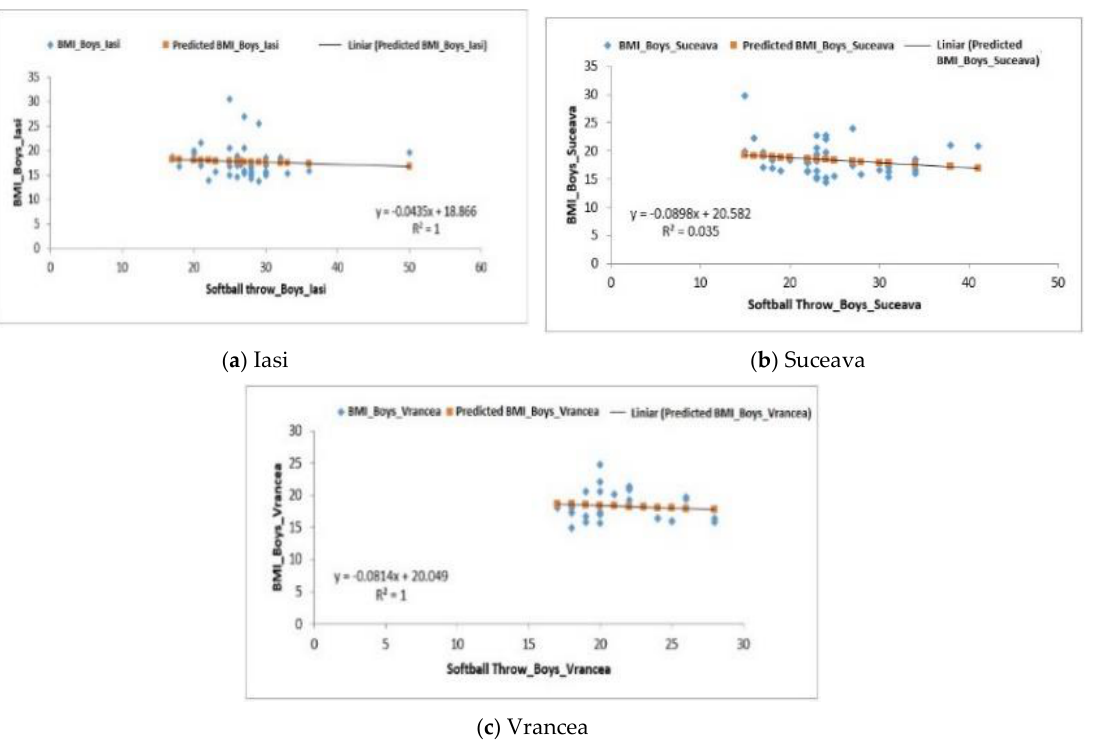
Figure 3. Relationship between the BMI and the softball throwing test for the male subjects in the three regions.